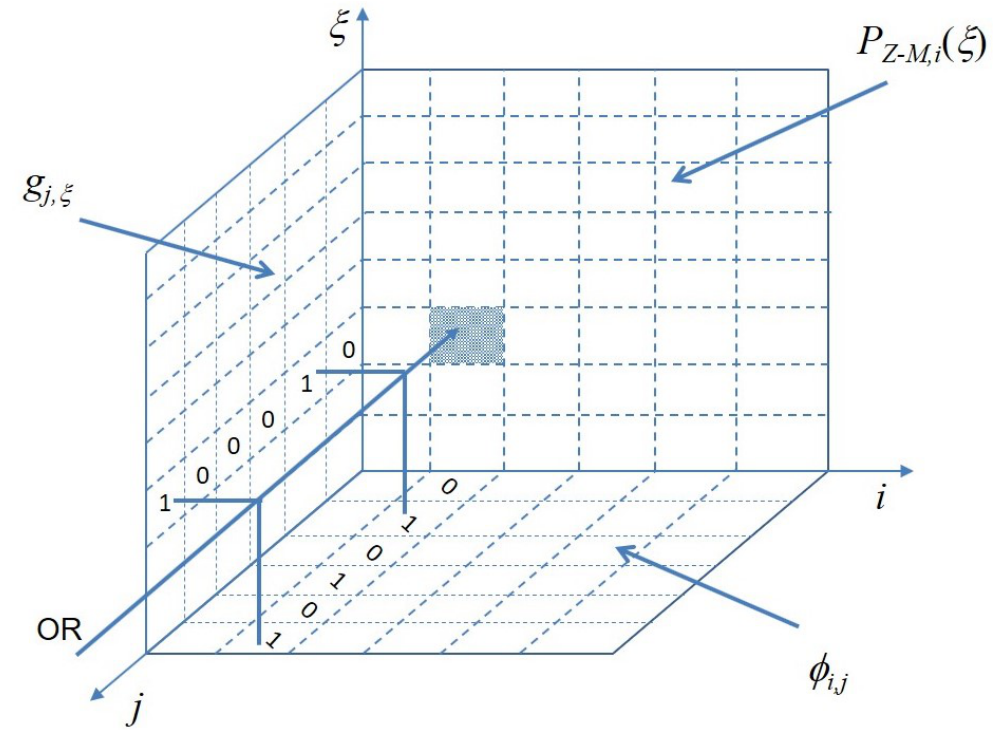
Figure 3. Mutual relation between